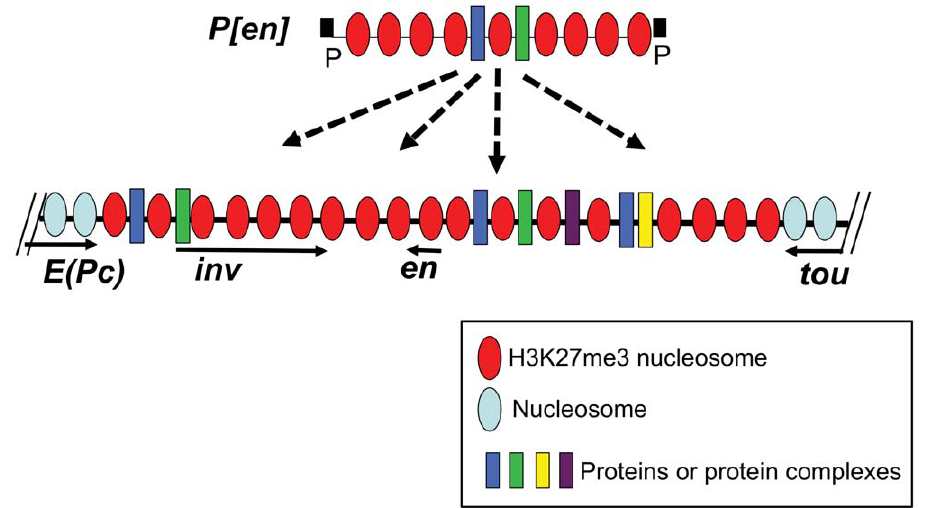
Figure 5. A model for P[en] homing. P[en] and the en/inv DNA are packaged in H3K27me3 nucleosomes (red ovals) [15]. Nucleosomes associated with tou and E(Pc) do not have the H3K27me3 mark (blue ovals) [15]. Specific proteins bound to both P[en] and en/inv DNA are represented by different colored rectangular boxes. We suggest that the en DNA in P[en] adopts the same chromatin structure and has the same proteins bound to it as in the genomic context. ( P[en] is not drawn to scale). Since the inv promoter is co-regulated with en , and also has a PRE associated with it, we draw its structure as identical to the en promoter. We suggest that P-element homing occurs through specific interactions between P[en] and multiple proteins bound to the genomic en/inv region and that chromatin structure also plays a role. These interactions cause P[en] to be concentrated in the vicinity of en/inv and then transposition occurs into en/inv and genes nearby.